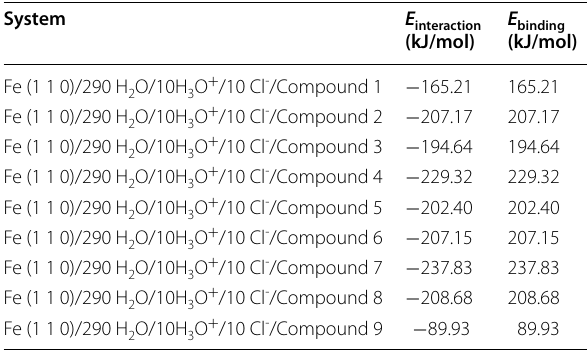
Table 11 Interaction (adsorption) and binding energies of inhibitor molecules with Fe (110) surface in hydrochloric acid